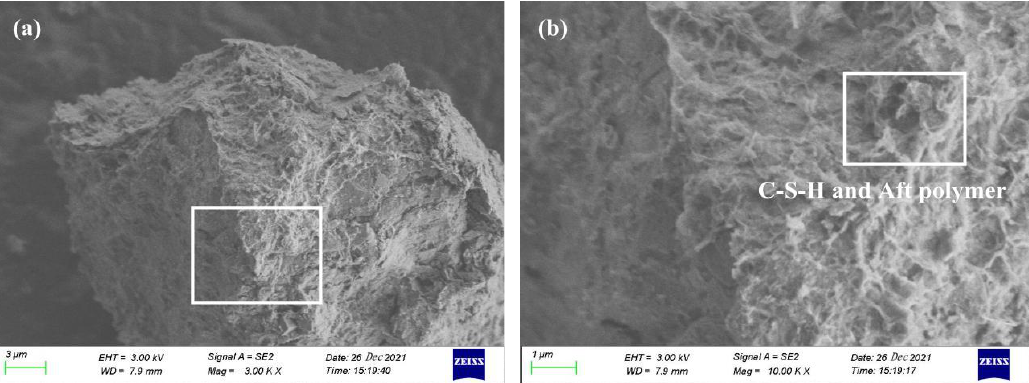
Figure 13. Composite-cemented soil cured for 60 d. ( a ) (3.00 kx magnification) and ( b ) (10.00 kx magnification).